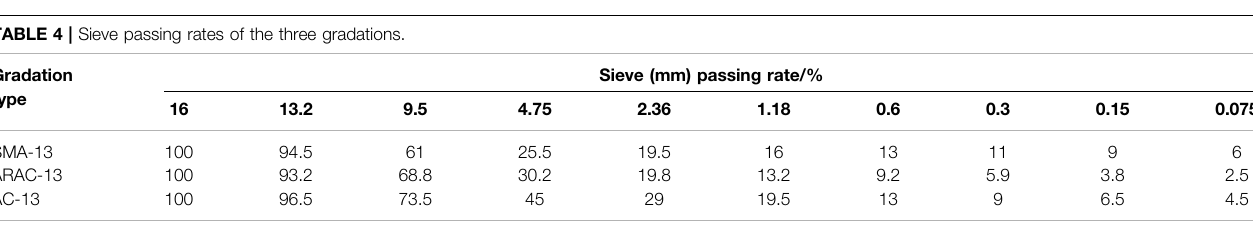
TABLE 4 | Sieve passing rates of the three gradations.